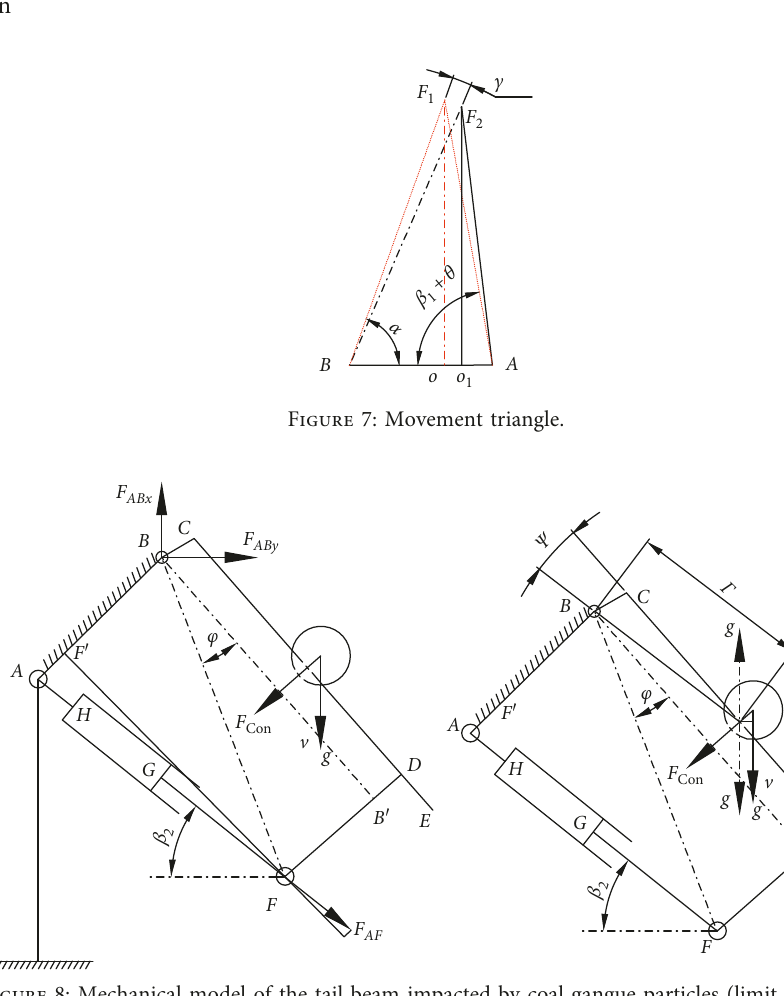
Figure 8: Mechanical model of the tail beam impacted by coal gangue particles (limit